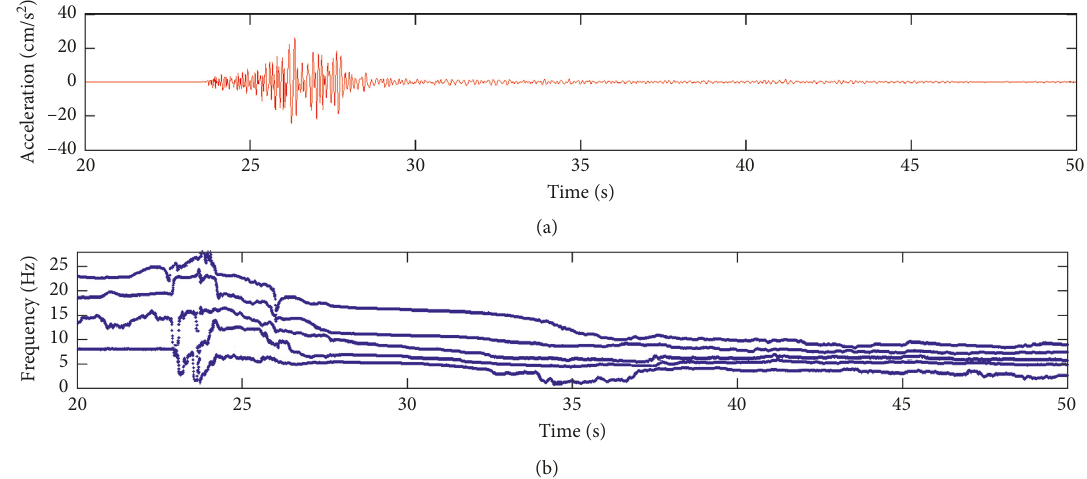
Figure 19: Time-varying modal identification results of the Pacoima dam using the Newhall earthquake data: (a) vibration response of channel 1; (b) identification results for